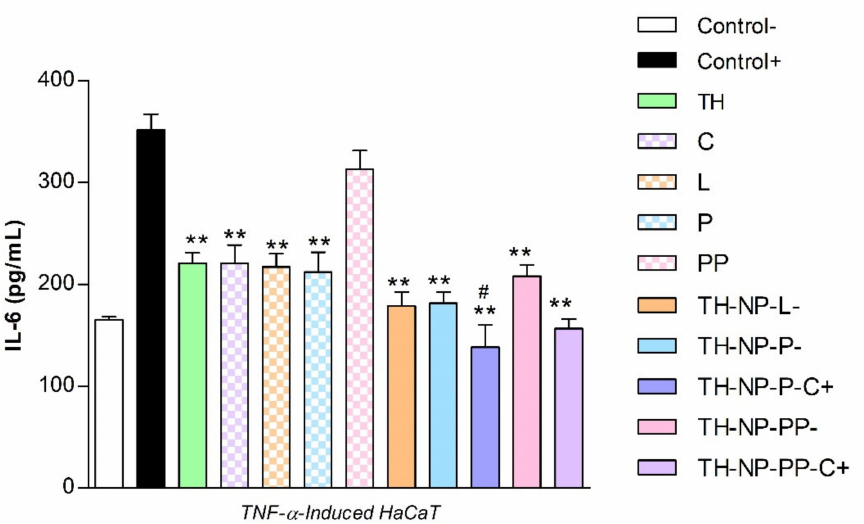
Figure 8. Quantification of secreted IL-6 by ELISA in TNF- α -stimulated HaCaT cells pre-incubated with formulated NPs and free compounds. Values of IL-6 (pg/mL) are the Mean ± SD, n = 3. Negative control: HaCaT cells without any treatment; Positive control: HaCaT cells treated only with TNF- α . Statistical analysis was performed by via one-way ANOVA, followed by Tukey’s Multiple Comparison Test. ** p < 0.001 compared to positive control, and # p < 0.01 compared to